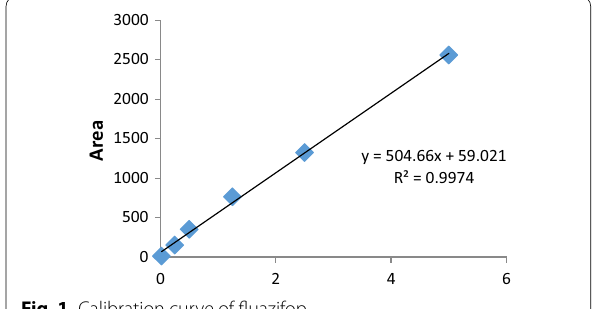
Fig. 1 Calibration curve of fluazifop